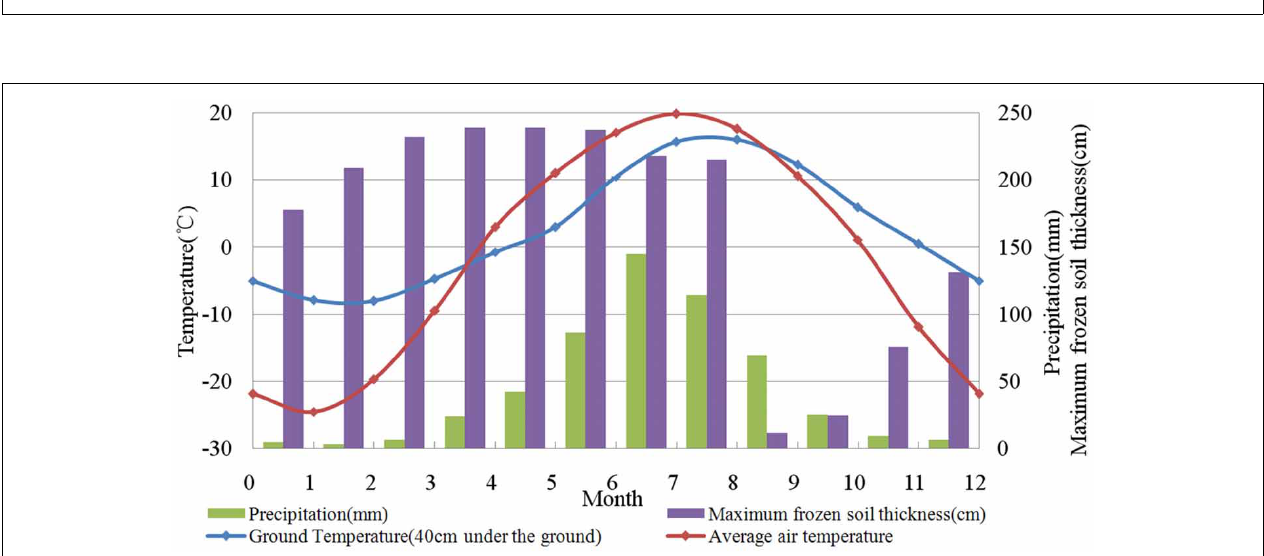
FIGURE 3 | Monthly average temperature/soil temperature in 40cm depth/permafrost thickness/precipitation in Sunwu County (1971–2000, Data: China Meteorological Data Sharing Service System).